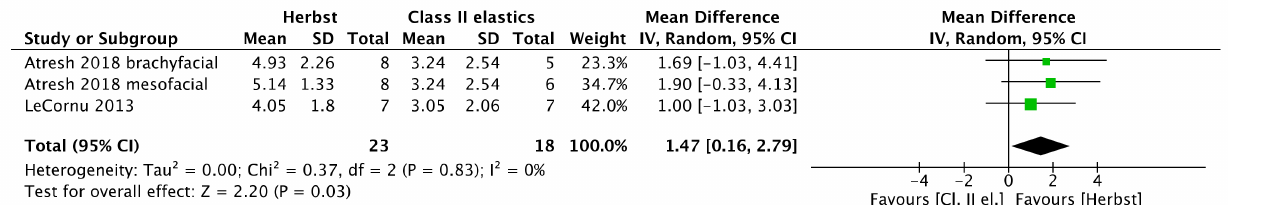
Figure 17. Forest plot of the right mandibular length changes using the random effects model [43,44].